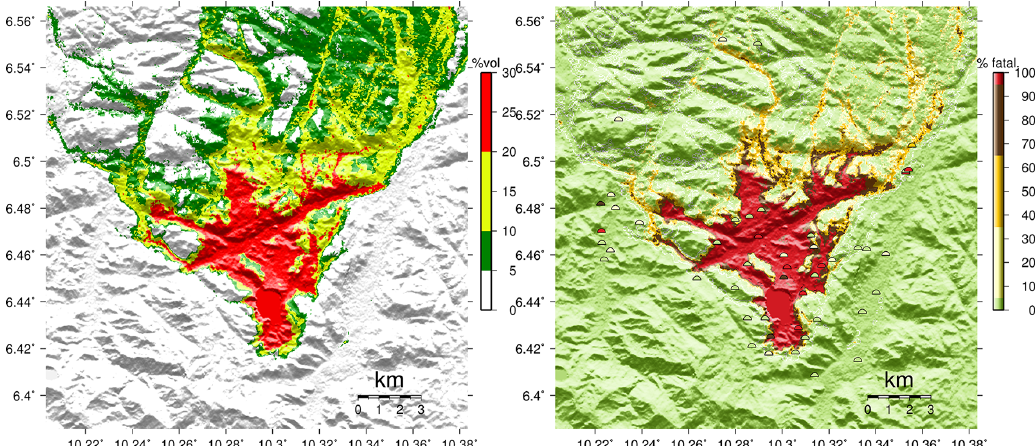
Figure 13. Best-fit simulation results. Left: maximum CO 2 concentration (%vol.) achieved at 1m height. Right: percentage of fatalities (in %) predicted by the model applying Eq. (7) at 1m height. Halved circles show the actual reported percentages at locations using the same colour scale.